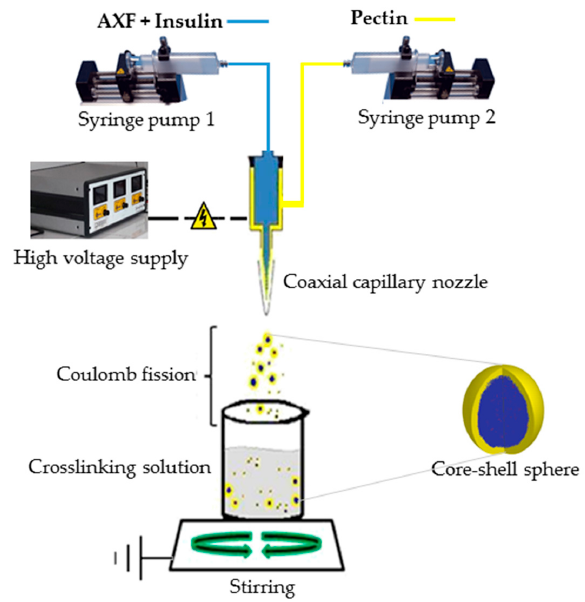
Figure 1. Diagram of coaxial-electrospray system used to produce pectin/arabinoxylan beads. (Adapted from Díaz-Baca et al., 2014 [26]). Table 1. Set of conditions from the statistical analysis.